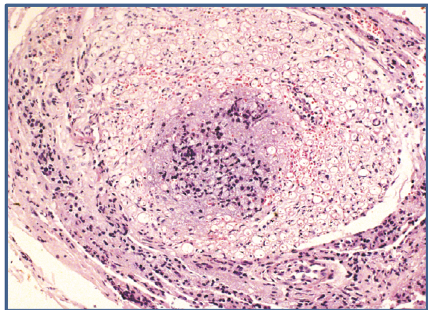
Figure 3: Cross section of the nerve showing endoneural invasion by the